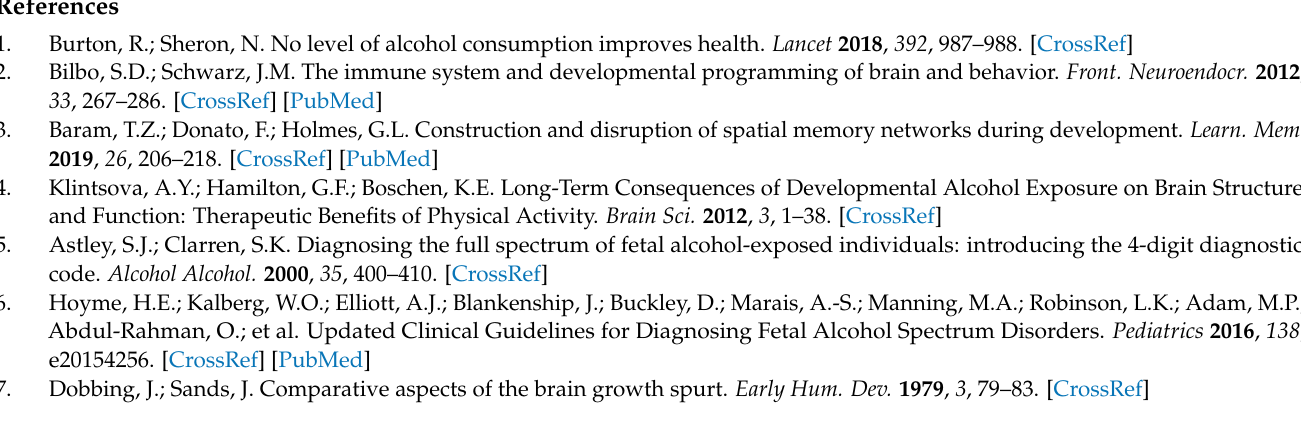
the only random effect in both models (random-intercept), Table S3: Regression table for linear mixed- effects model examining stereotaxic coordinate of the center of AAVrg-CAG injection into mPFC along the anterior-posterior axis (left), medial-lateral axis (middle), and dorsal-ventral axis (right). Litter was the only random effect in at three models (random-intercept), Table S4: Regression table for linear mixed-effects model examining stereotaxic coordinate of the center of AAVrg-CAG injection into vHPC along the anterior-posterior axis (left), medial-lateral axis (middle), and dorsal-ventral axis (right). Litter was the only random effect in at three models (random-intercept), Table S5: Regression table for linear mixed-effects model examining diffusion of AAVrg-CAG in-jections into mPFC (left) and vHPC (right). Litter (random-intercept) and fluorophore-site pairing (random-intercept) were the random effects in both models, Table S6: Regression table for Re → (mPFC+vHPC) projection neurons, adding additional control predictors to the analysis from Table 4, Table S7: Regression table for Re → mPFC projection neurons, adding additional control predictors to the analysis from Table 5. Table S8: Regression table for Re → vHPC projection neurons, adding additional control predictors to the analysis from Table